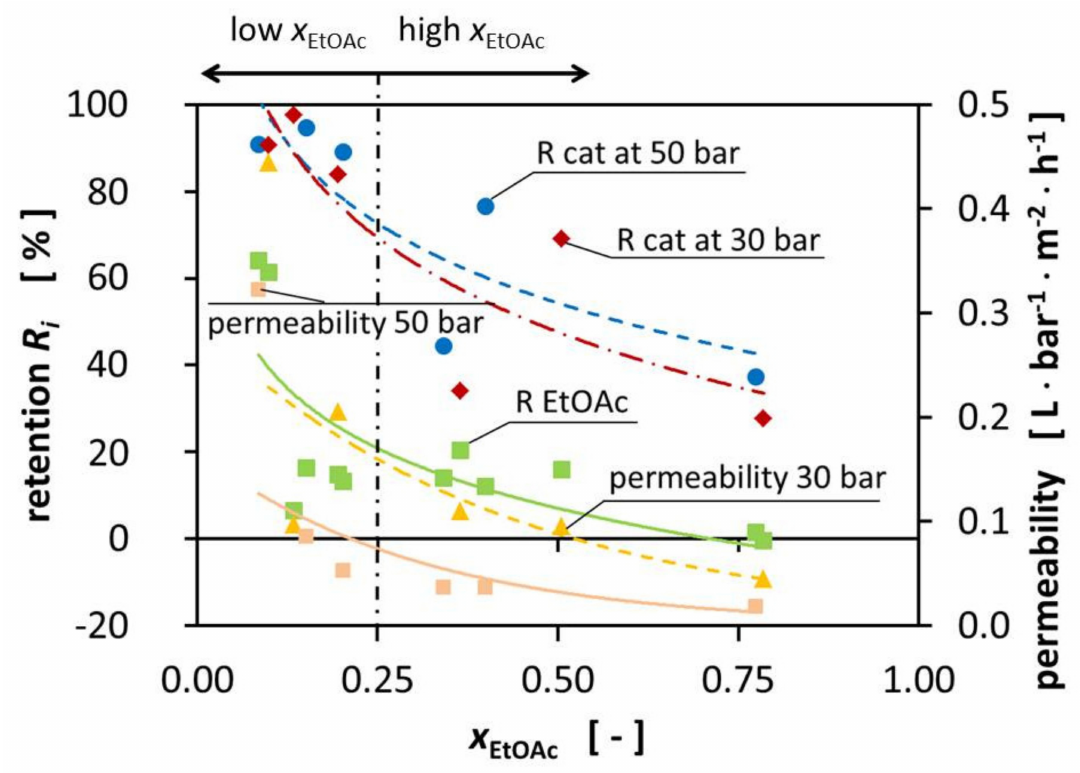
Figure 2. Retention of the catalyst (50 bar TMP blue dot, 30 bar TMP red diamond) and EtOAc (green square) and permeability (30 bar TMP yellow triangle, 50 bar TMP orange square) over the EtOAc molar fraction at room